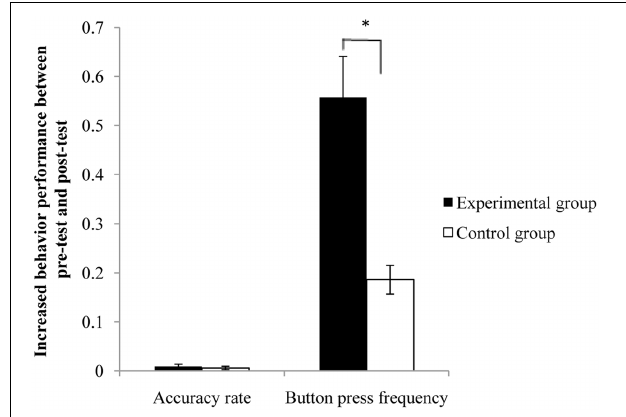
FIGURE 2 | Behavioral changes between the pre- and post-test for the two groups. The increase of button press frequency from pre-test to post-test was significantly greater in the experimental group than that in the control group. Error bar means the standard error. * p < 0 . 05.